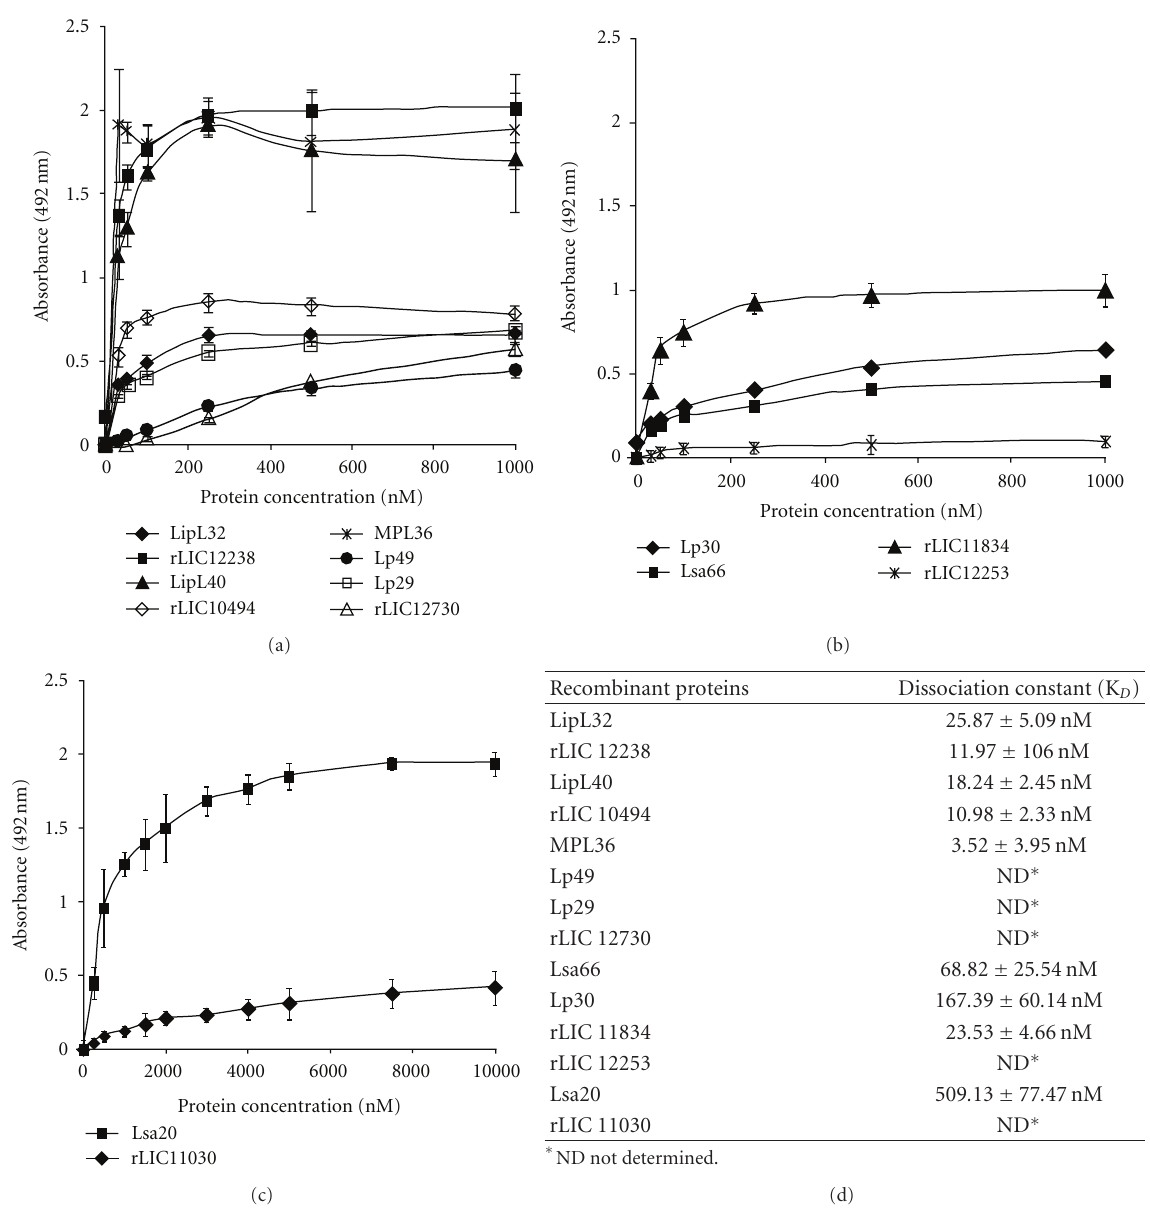
Figure 8: Characterization of recombinant proteins binding to PLG. In (a) , (b), and (c) PLG (10 μ g/mL) was immobilized in 96-well ELISA plates, and each recombinant protein at 0 to 1,000 nM was added for interaction. The binding was detected using antiserum raised in mice against each protein at appropriate dilutions (1:4,000 for LipL32; 1: 5,000 for rLIC12238, LipL40, and MPL36; 1 :1,000 for Lp29, Lp49, Lsa20, and rLIC11030; 1:500 for rLIC12730, Lsa66, and Lp30; 1:750 for rLIC11834 and rLIC12253), followed by horseradish peroxidase- conjugated anti-mouse IgG. Data represent the mean absorbance values ± the standard deviation of six replicates for each experimental group. The results are representative of two independent experiments. In (d) The dissociation constant ( K D ) was calculated based on ELISA data for the recombinant proteins that reached equilibrium up to a concentration of 1,000